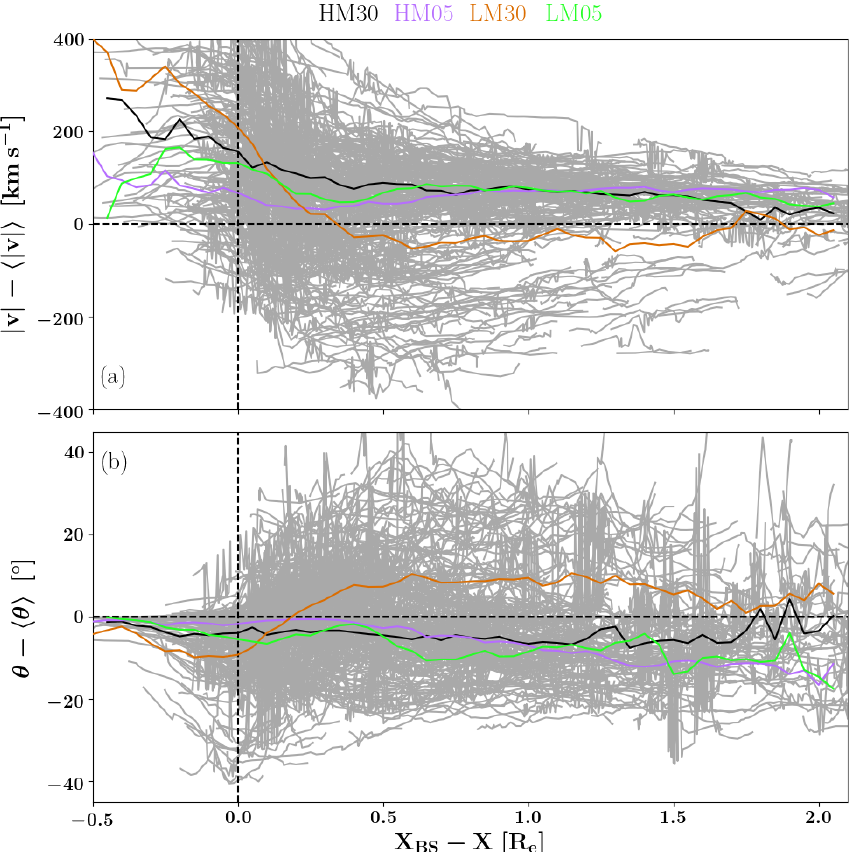
Figure 11. Jet velocity deflection away from the Sun–Earth line relative to the background magnetosheath velocity, in terms of (a) magnitude of velocity deflection and (b) angle of the velocity deflection. See text for details on the definition of the depicted parameters. The grey lines indicate all events, while different colours refer to the superposed epoch averages from the different runs, identified with a run identifier (see Table 1): orange and green (black and purple) are the low (high) M A runs, respectively.